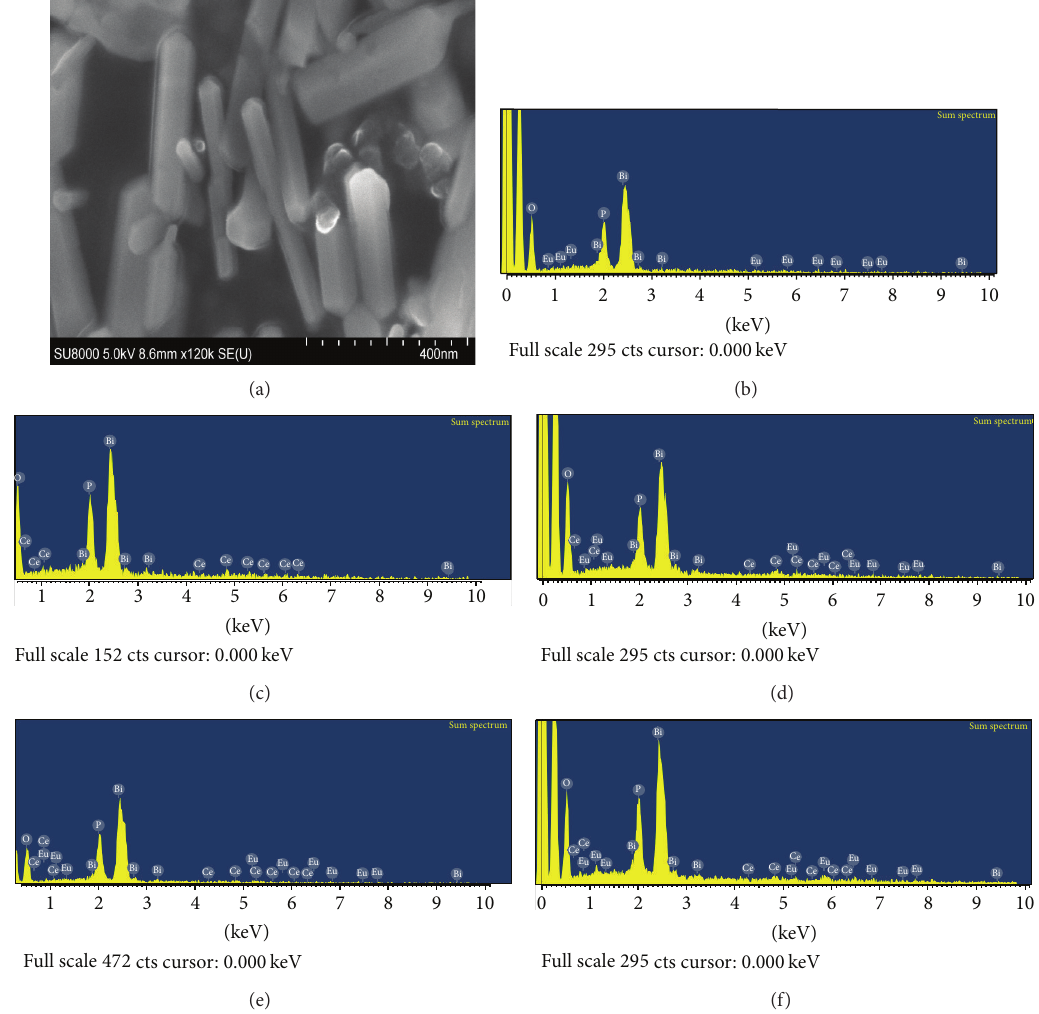
Figure 2: (a) SEM image of the 1.0 mol% Eu 3+ doped sample, (b–f) EDAX profiles of all the synthesized samples.